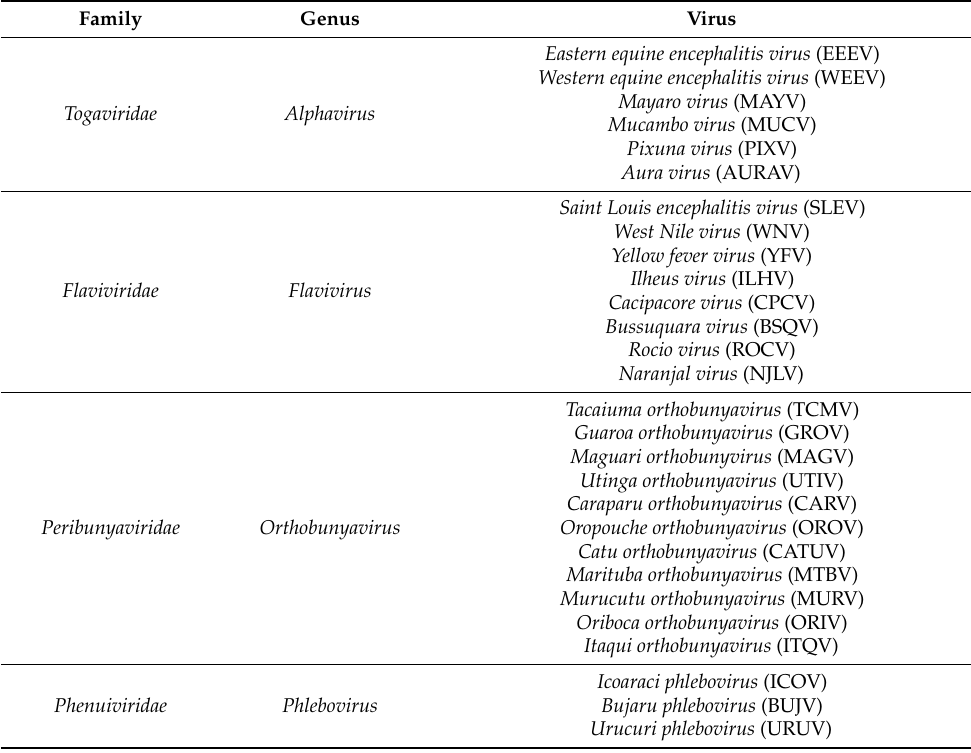
Table 1. Panel of arboviruses used in the HI to detect antibodies in sera from free-ranging birds captured in APA-Belem, Par á ,